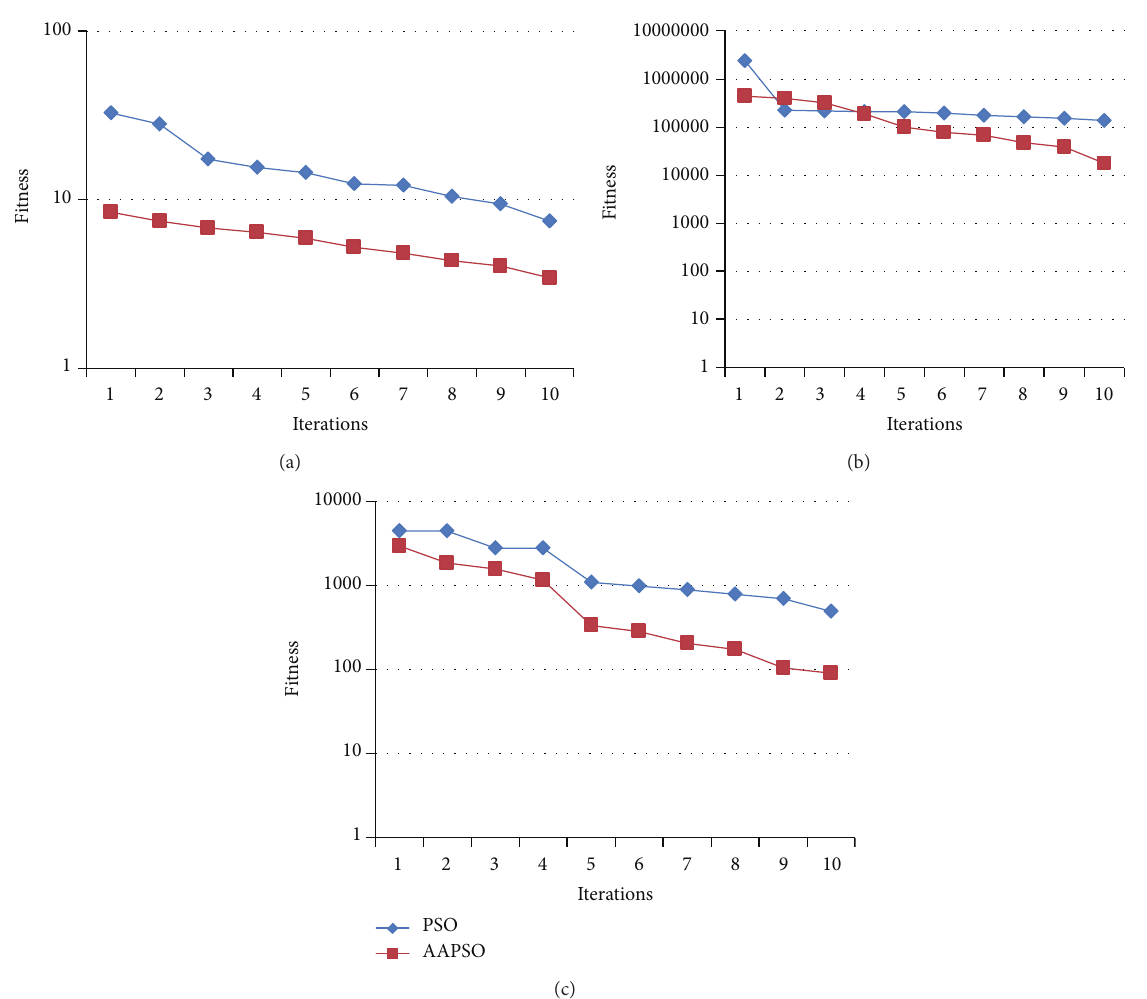
Figure 5: Performance of AAPSO and PSO methods with (a) sphere, (b) Rosenbrock, and (c) Rastrigin.